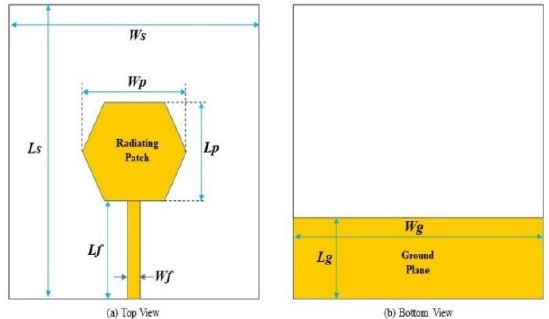
Fig. 3. Design details of dimensions of HMSA Table 1. Parameters design details of